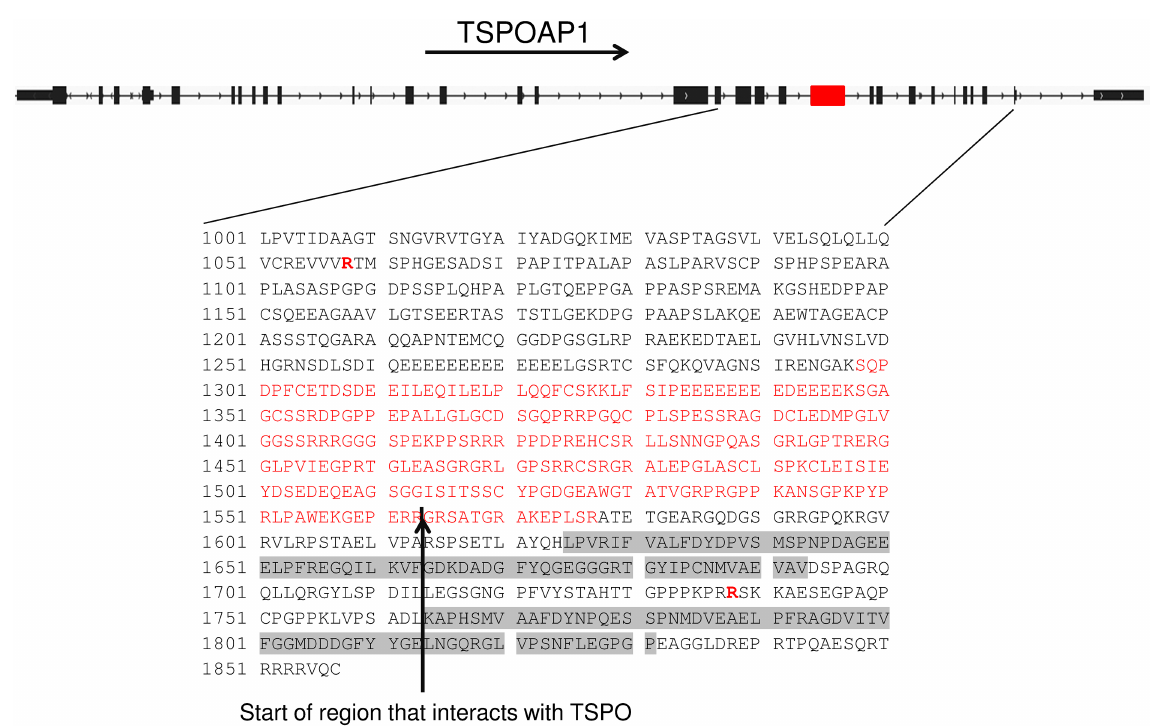
Fig 4. TSPOAP1 variants in FECD patients. The locations of two substitution variants in the primary sequence of TSPOAP1 are shown in bold red (positions 1058 and 1738) under a diagram of the structure of the TSPOAP1 gene. The exon that is preferentially excluded from RE + samples by alternative splicing is shown in red, and the location of this sequence in the TSPOAP1 protein is also shown in red (position 1298– 1577). The vertical black arrow designates the start of the region of the TSPOAP1 protein that is thought to interact with TSPO.